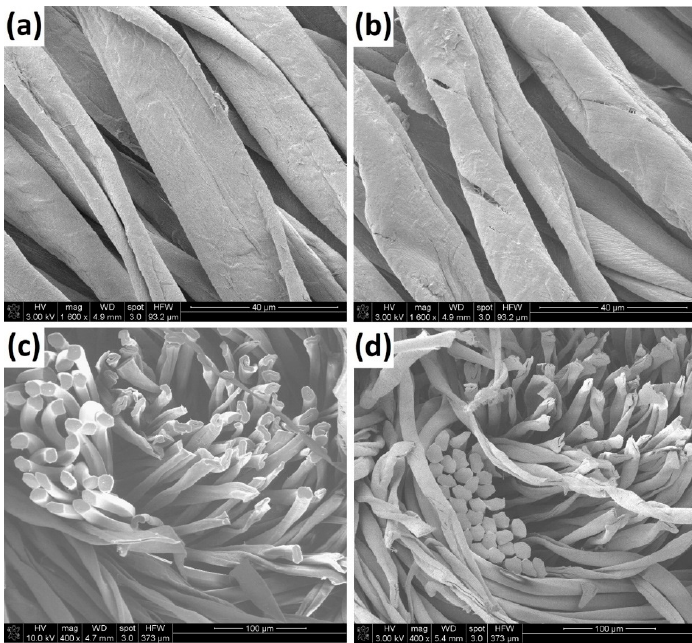
Figure 2. SEM images of Sample 2 (CO 79/PES 21): Cotton fibres surface (magnification 1600×) ( a ) before exposure and ( b ) after radiant heat exposure (10 kW·m − 2 , 40 s); cross-section of yarn (magnification 400×) ( c ) before exposure and ( d ) after radiant heat exposure (10 kW·m − 2 , 40 s).